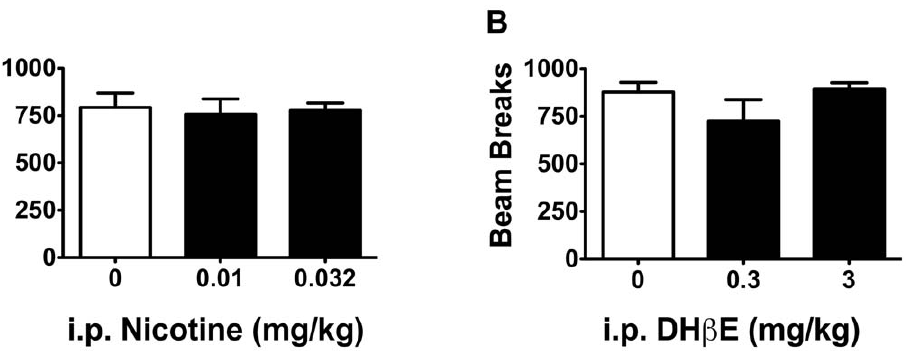
Figure 5. Nicotine and DH b E did not affect locomotor activity. Doses of A) nicotine (n=5 2 6) and B) DH b E (n=4 2 5 per group) that promoted anxiolytic-like behavior in the CER and marble burying tasks did not affect locomotor activity as measured by beam breaks ( F s =0.072, 1.451, p s . 0.05). Data are presented as means 6 SEM.